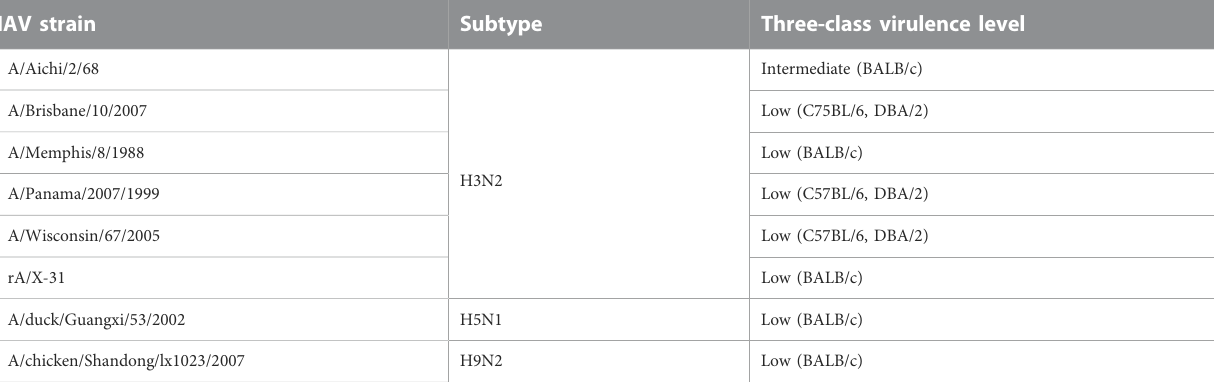
TABLE 6 IAV strains with a Methyl-accepting chemotaxis protein (MCP) signaling domain assigned to M1 gene segment instead of alpha-catenin/vinculin-like.